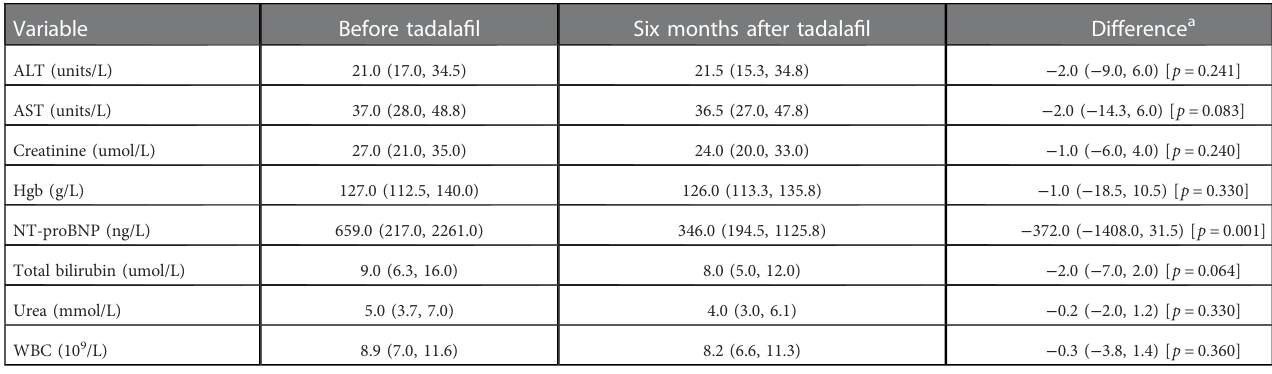
TABLE 5 Biochemical measures before and Six months after tadala fi l, summarized as median (Q 1 , Q 3 ). Variable Before tadala fi